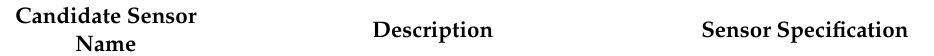
Table 1. List of candidate sensors and their details.